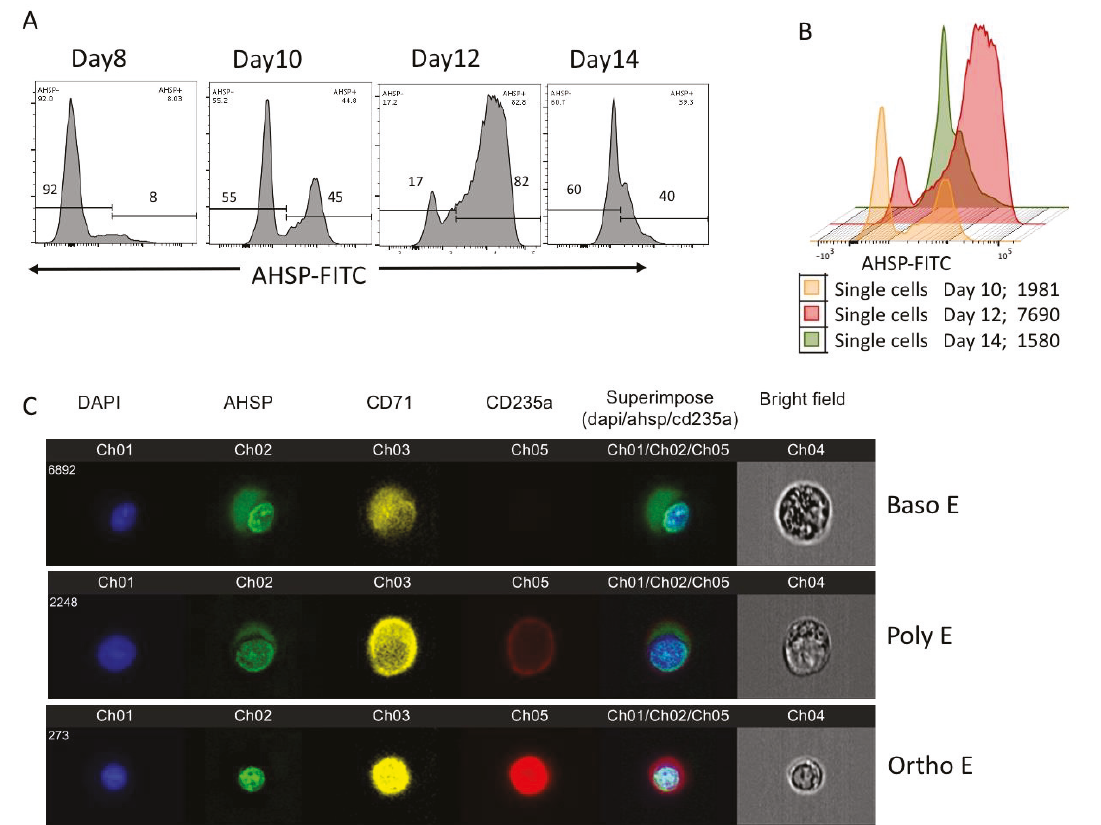
Figure 4. AHSP protein expression in human peripheral blood mononuclear cells. ( A ) Percentage of AHSP positive and negative cells in FACS analysis on culture days 8, 10, 12 and 14. ( B ) Overlay of AHSP protein expression displayed with color graphs on Day 10 (orange), Day 12 (red) and Day 14 (green) showing highest MFI shifted to right on Day 12. ( C ) Representative images from AMNIS image flow of AHSP expression in basophilic erythroblast (Baso E), polychromatophilic erythroblasts (Poly E) and orthochromatophilic (Ortho E) cell types. Cells were examined in all four fluorescent channels and brightfield. Blue stain is the nuclear stain DAPI, green is the AHSP marker, yellow is the transferrin marker CD71 and red is the glycophorin A marker CD235a. The superimposed image shows a combination of CD235a, AHSP and